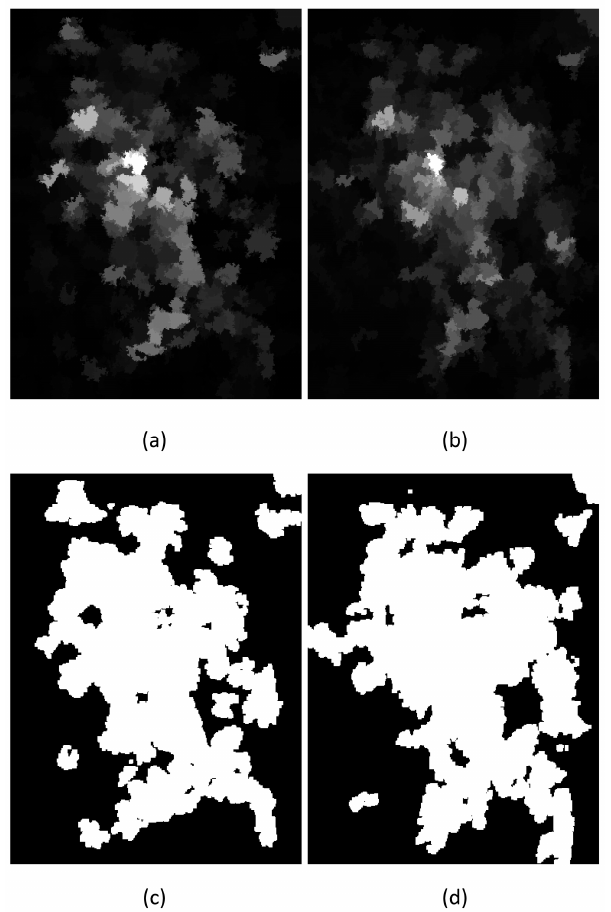
Figure 4. Saliency rate of ( a ) VV and ( b ) VH polarizations, and saliency map of ( c ) VV and ( d ) VH polarizations. ( d ) VH